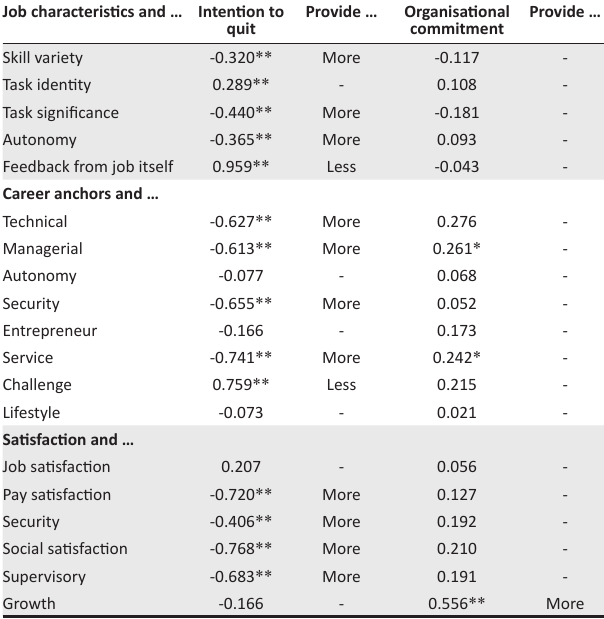
TABLE 4: Retention model for non-professional workers in the private healthcare